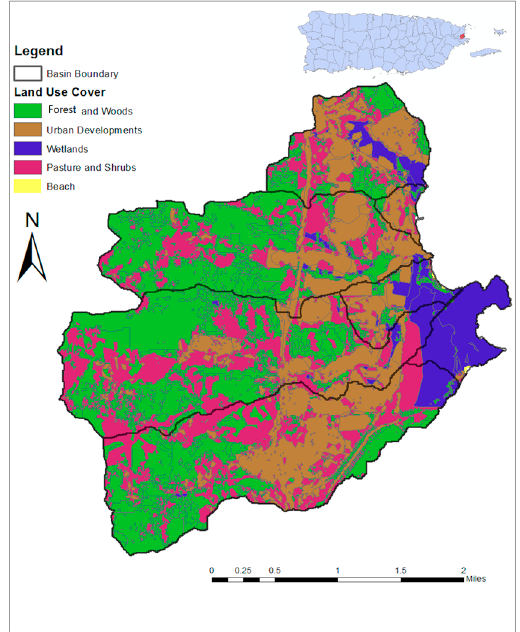
Figure 5. Land cover use within the area of interest for the 2006 conditions. The watershed boundaries are shown with a black solid line. The land use cover divides into the following categories within the area of interest: Forrest and Woods, Urban Developments, Wetlands, Pasture and Shrubs and Beach [20].